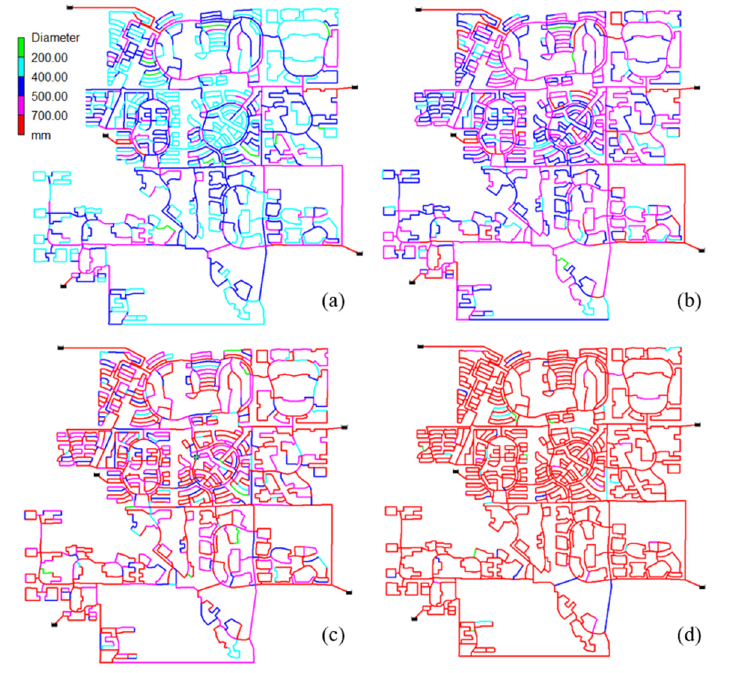
Figure 7. Design results of pipe diameters for the four selected solutions: ( a ) solution 1, ( b ) solution 2, ( c ) solution 3, and ( d ) solution 4.